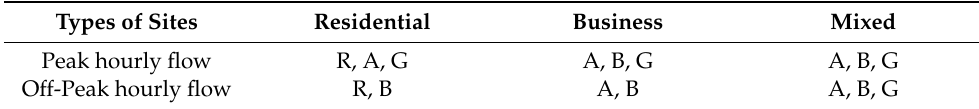
Table 4. Types of gross floor area after screening.